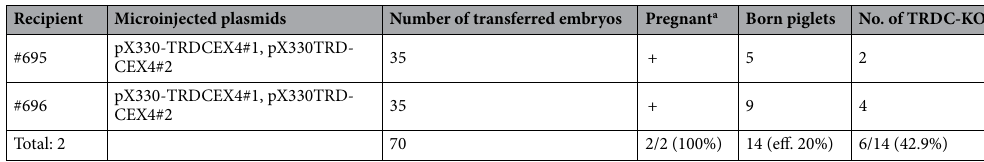
Table 1. Results of the intracytoplasmic microinjection of CRISPR/Cas9 targeting exon 4 of the porcine TRDC locus in porcine zygotes. a Pregnancy was detected on day